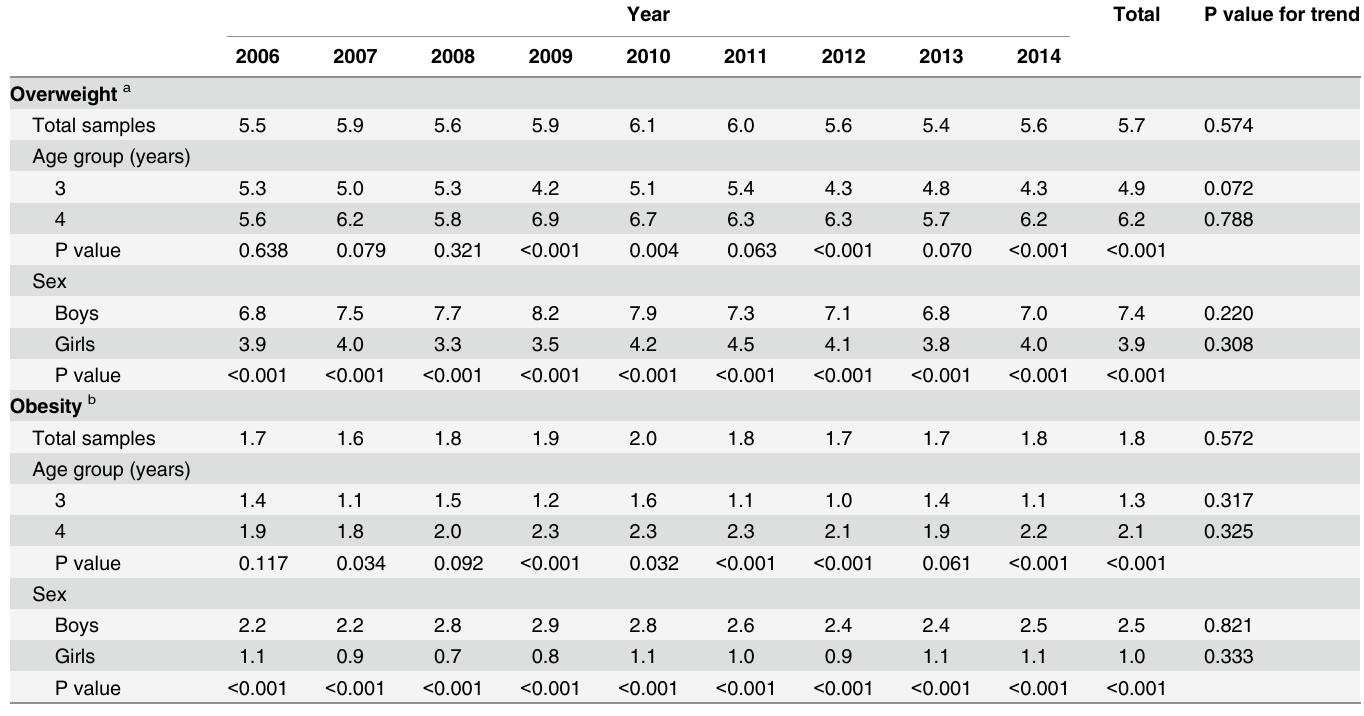
Table 3. Prevalence of overweight and obesity in the children at 3 – 4 years old in Tianjin from 2006 to